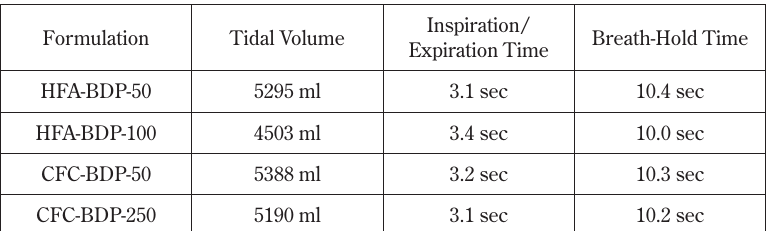
Table 1 Physiological parameters measured during the in vivo lung deposi- tion studies comparing HFA and CFC